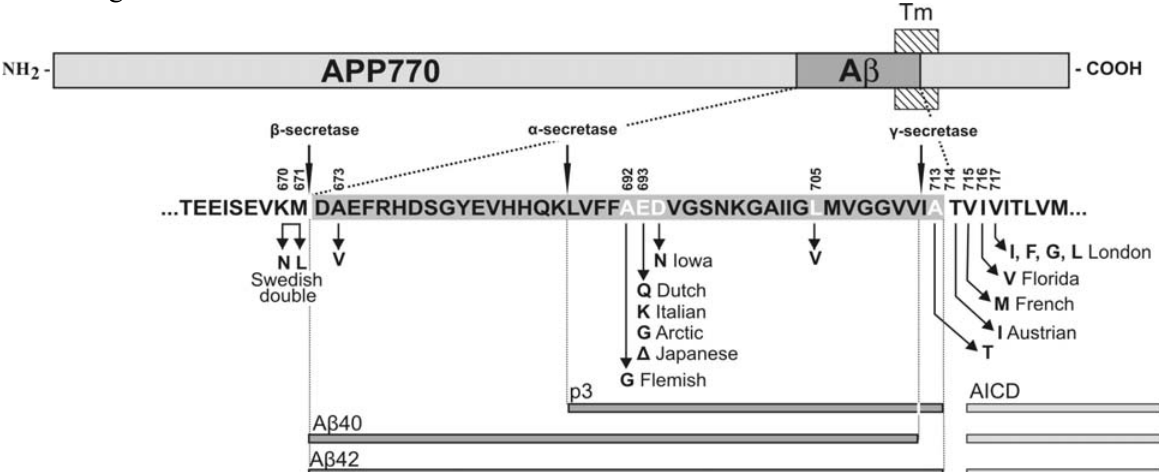
Figure 1. Schematic representation of amyloid precursor protein (APP), positions of the A β sequence, transmembrane domain of APP (Tm), and sites of α -, β - and γ -secretase